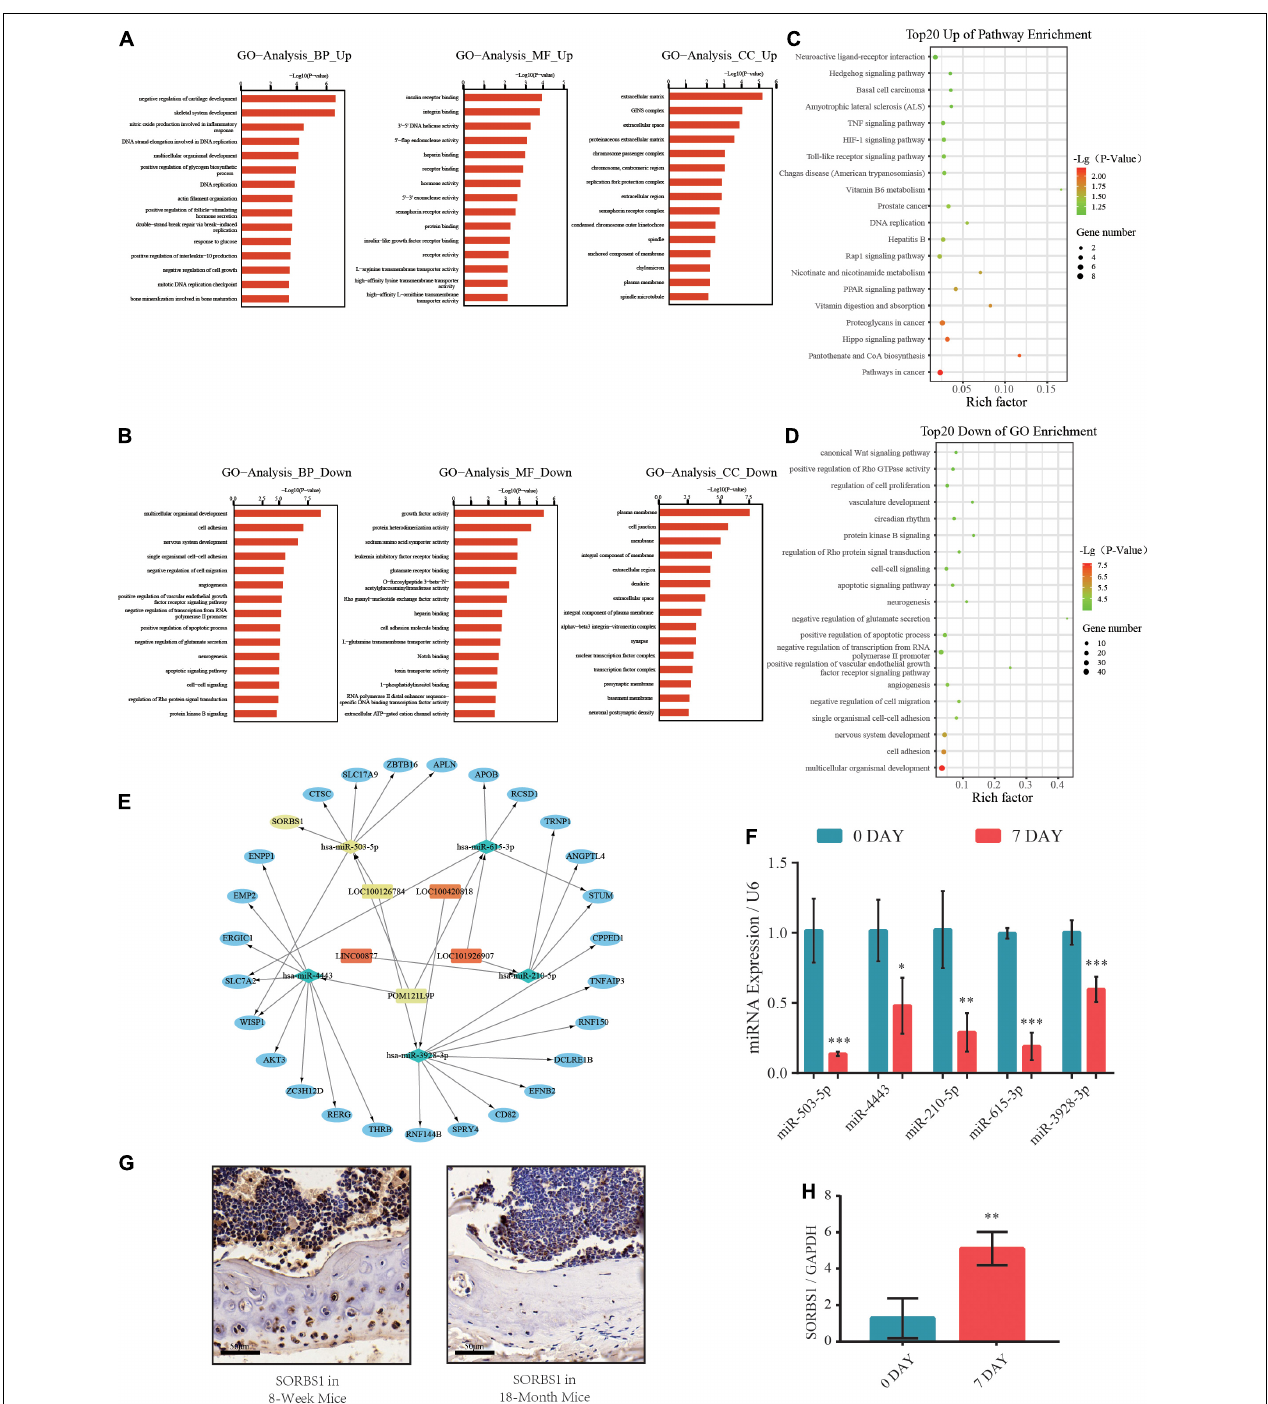
FIGURE 2 | Gene ontology (GO) and Kyoto Encyclopedia of Genes and Genomes (KEGG) pathway analyses of differentially expressed genes (DEGs) in competing endogenous RNA (ceRNA) network. (A,B) Significantly upregulated and downregulated GO annotations with top 20 scores. (C,D) Significantly upregulated and downregulated KEGG pathway annotations with top 20 scores. (E) Construction of predicted miRNA-mRNA network core in osteogenic differentiation. (F) Relative expression levels of miR-503-5p, miR-4443, miR-210-5p, miR-615-3p, and miR-3928-3p used to distinguish between undifferentiated (day 0) and osteogenically differentiated (day 7) groups. (G) SORBS1 levels in femoral cortices and bone marrow of young mice (8 weeks) and aged mice (18 months) as determined using immunohistochemistry (IHC). Scale bar, 50 µ m. (H) Relative expression levels of SORBS1 in undifferentiated (day 0) and osteogenically differentiated (day 7) groups, as measured by RT-qPCR. GAPDH served as an endogenous control for mRNAs, and U6 acted as an endogenous control for miRNAs. Quantitative data are presented as mean ± standard deviation (SD) of three independent experiments; * p < 0.05, ** p < 0.01, *** p < 0.001.